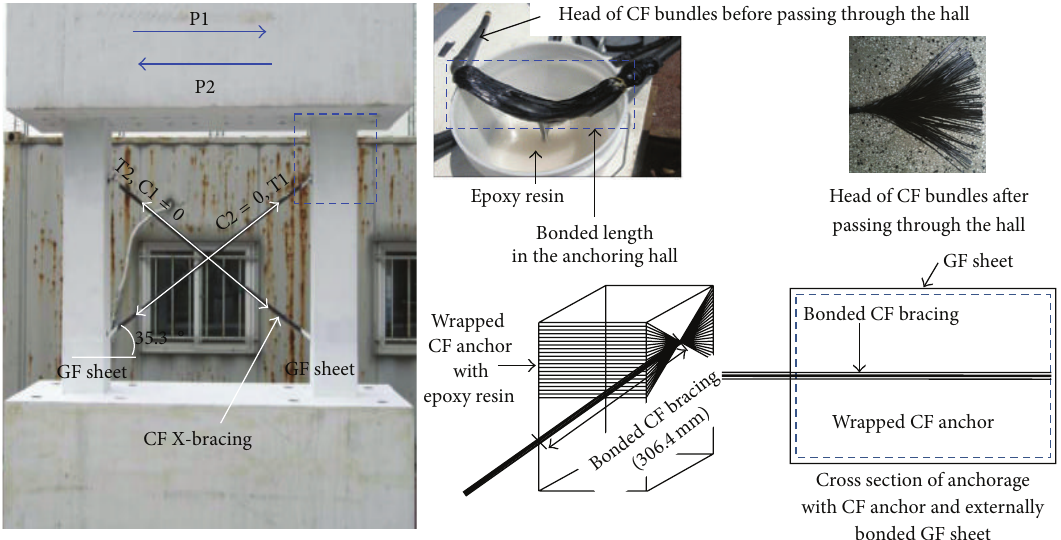
Figure 1: A schematic diagram showing the hybrid CF X-bracing and GF sheet wrapping